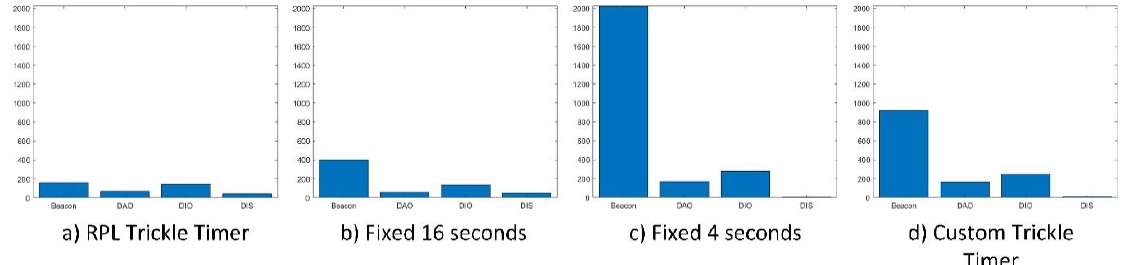
Figure 11. The number of packets for different EB period configurations.